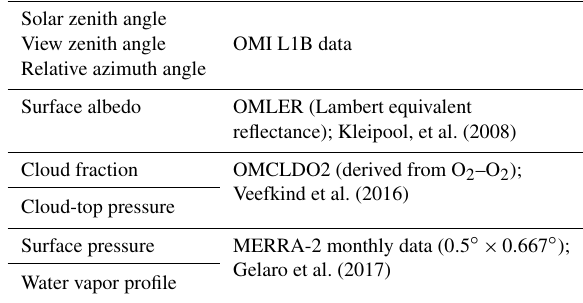
Table 2. Parameters used in AMF